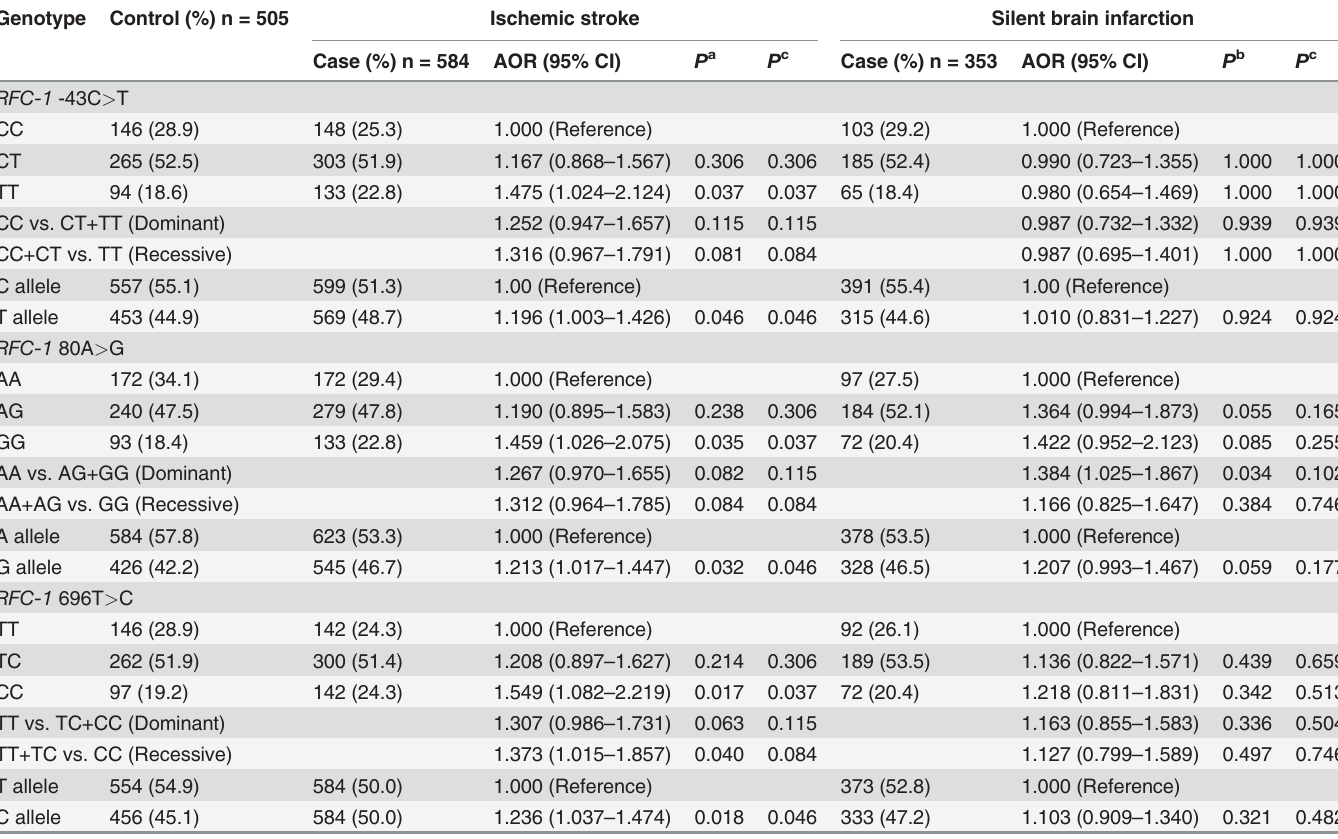
AOR, adjusted odds ratio; 95% CI, 95% con fi dent interval. a P -values on the basis of risk factors such as age, gender, hypertension, hyperlipidemia, diabetes mellitus, and smoking. b P -values on the basis of risk factors such as age, gender, hypertension, hyperlipidemia, and diabetes mellitus.